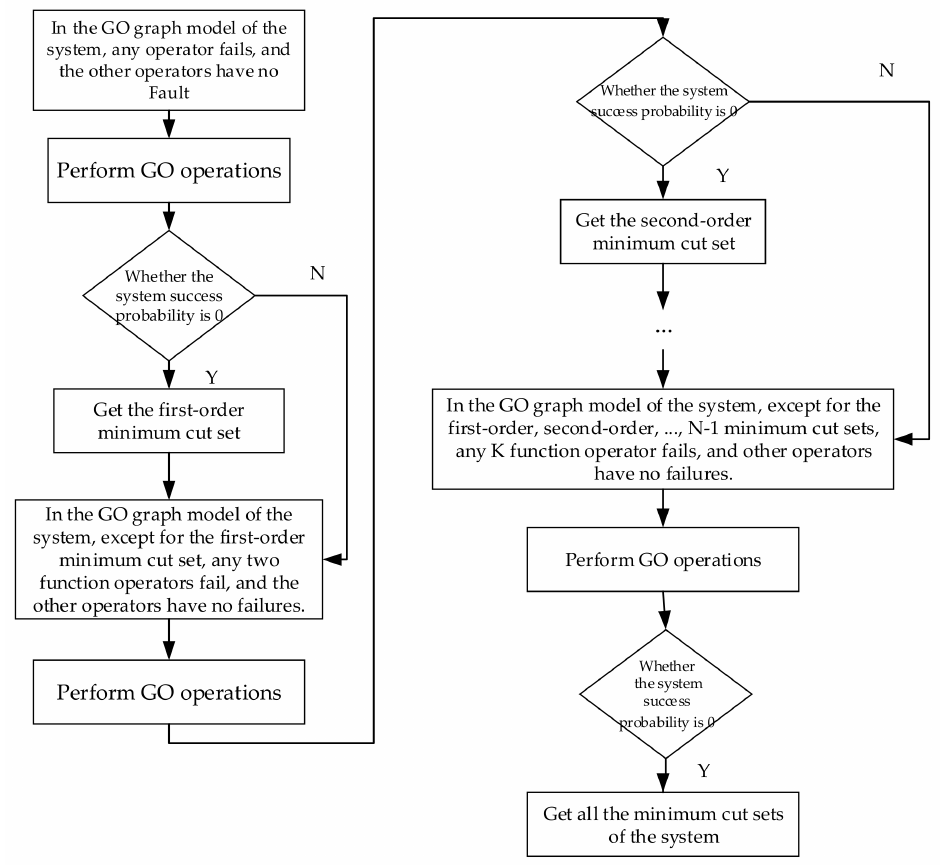
Figure 1. The qualitative analysis flowchart of the GO